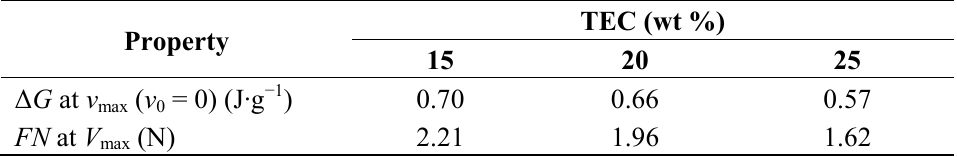
Table 5. Specific energy input per unit mass at maximum drawdown velocity and foamability number at maximum draw ratio of externally plasticized